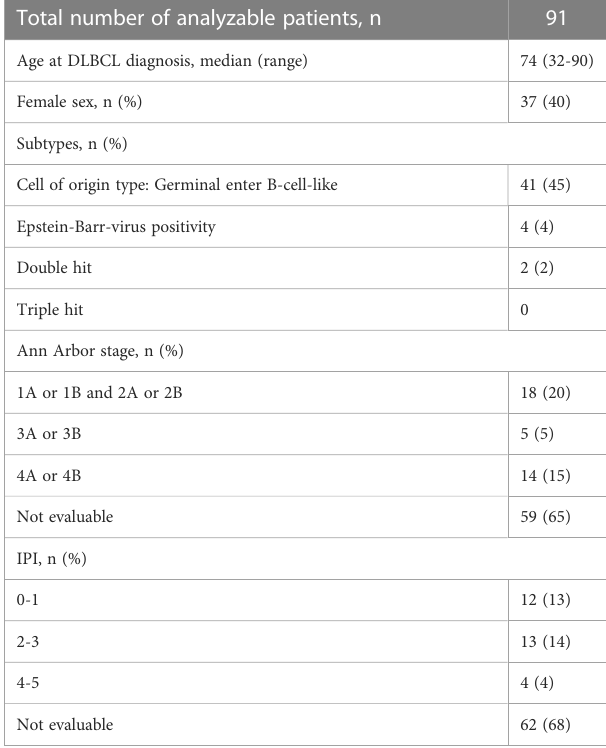
lymphoplasmacytic lymphoma, chronic lymphatic lymphoma, and one case of angioimmunoblastic T-cell lymphoma.